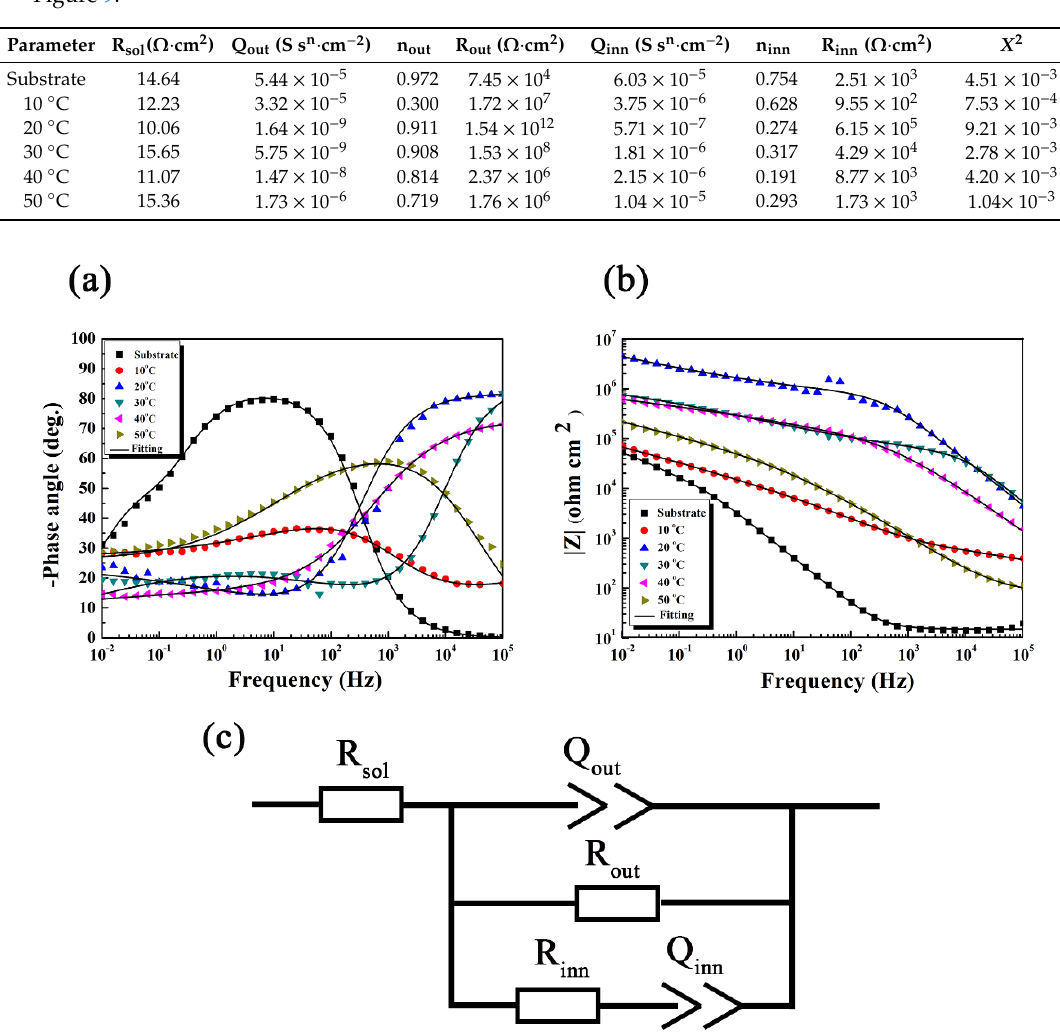
Table 4. Fitted parameters for the electrochemical impedance spectroscopy (EIS) spectrum depicted in Figure 9.